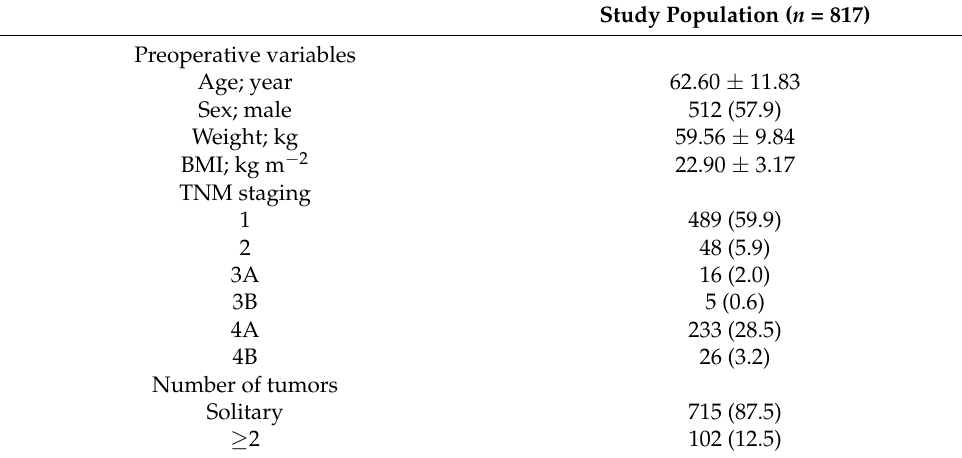
Table 1. Demographic and perioperative variables of the study